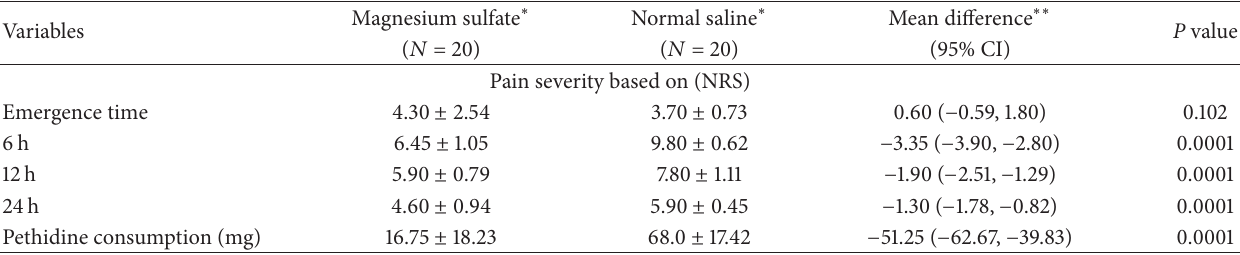
Figure 2: Flow of participants. Table 2: The comparison of NRS mean in different time between two groups and mean postoperative analgesic consumption in two groups over 24